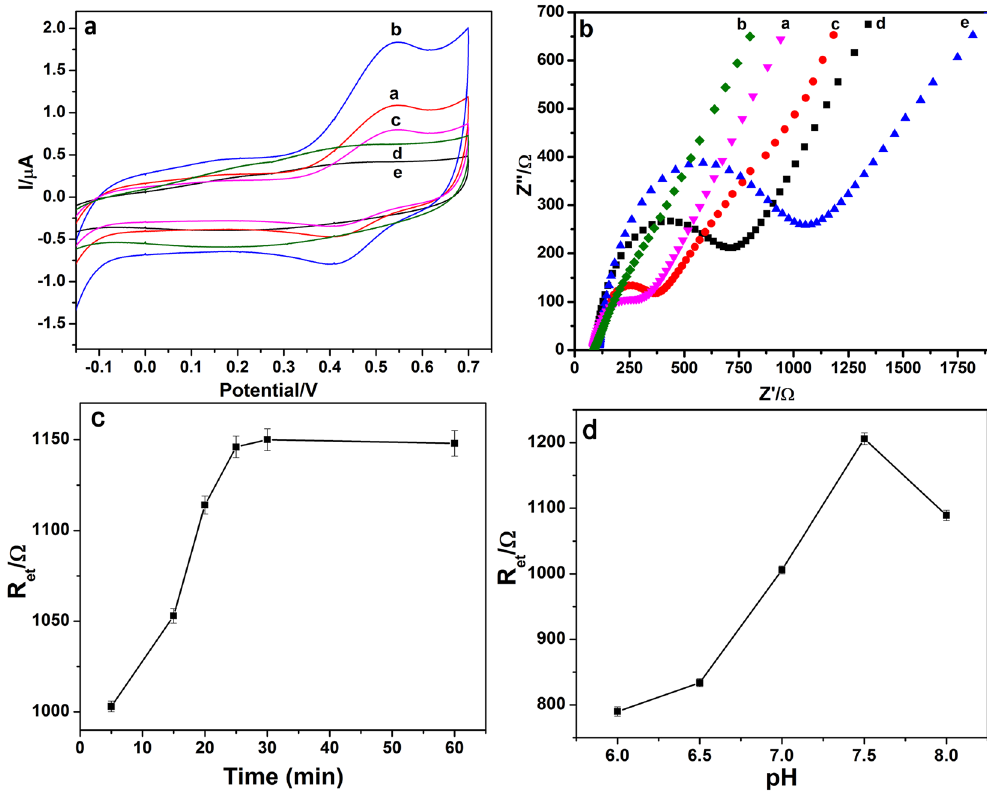
Figure 3. CV responses ( a ) and EIS ( b ) of the different modified electrodes in 0.1 M PBS containing 5 mM K 3 [Fe(CN) 6 ]/K 4 [Fe(CN) 6 ] containing 0.1 M KCl, respectively. Bare Au (curve a), electrode modified successively with Au/r-GO nanocomposites (curve b), mixture of capture anti-LC3B-II (Ab 1 ) and anti-Beclin-1 (Ab 1 ) (curve c),mixture of 10 ng/mL LC3B-II and Beclin-1 (curve d), mixture of anti-Beclin-1 (Ab 2 )/Au NCs and anti-LC3B-II (Ab 2 )/Au NCs (curve e). Effect of the incubation time ( c ) and pH ( d ) on the response of the